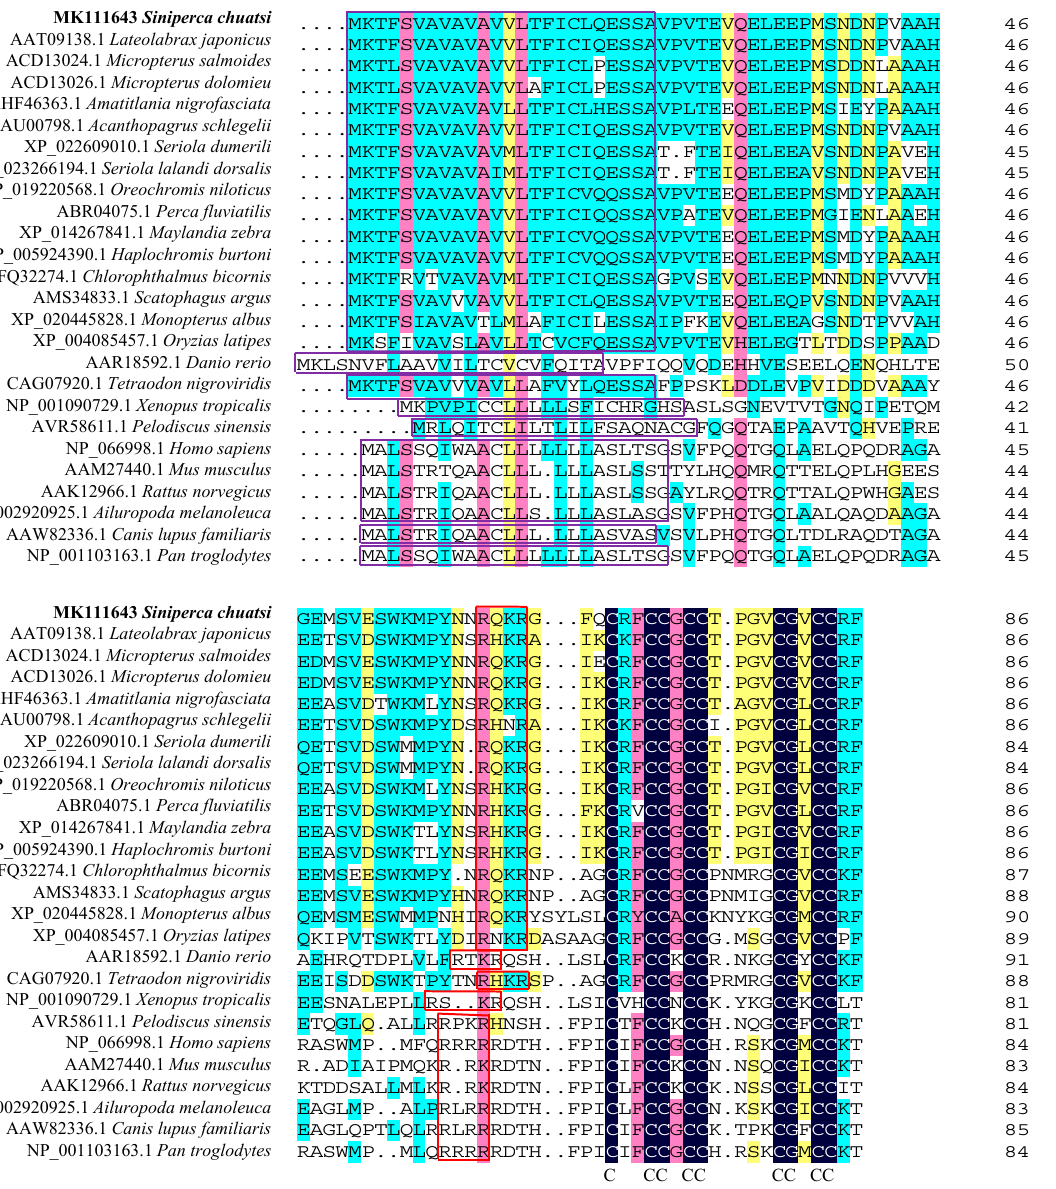
Figure 2. Multiple-sequence alignment of the hepcidin protein. The dark blue regions indicate completely identical amino acid sequences. The pink, cyan, and yellow regions indicate amino acid similarities greater than 75%, 50%, and 33%, respectively. The purple and red squares indicate signal peptide and RX(K/R)R motif, respectively. Mazarine represents the conserved eight cysteine residues. Phylogenetic analysis showed that Sc-hep exhibited high similarity to its homologs from M. salmoides , M. dolomieu , L. japonicus , and A. schlegelii (Figure 3). The genetic relationship between species is consistent with their traditional taxonomic status.